Question: From the figure, is the trend upward or downward?
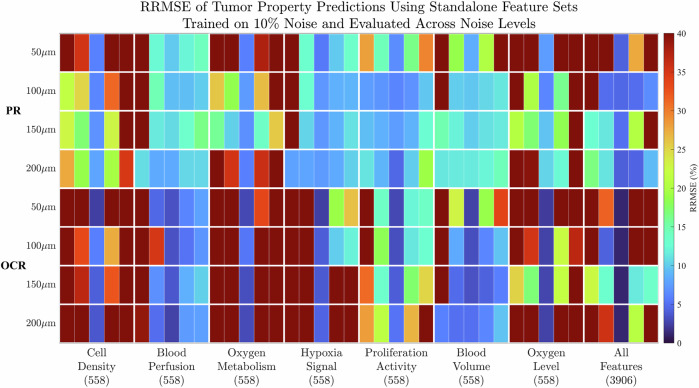
Answer: increasing